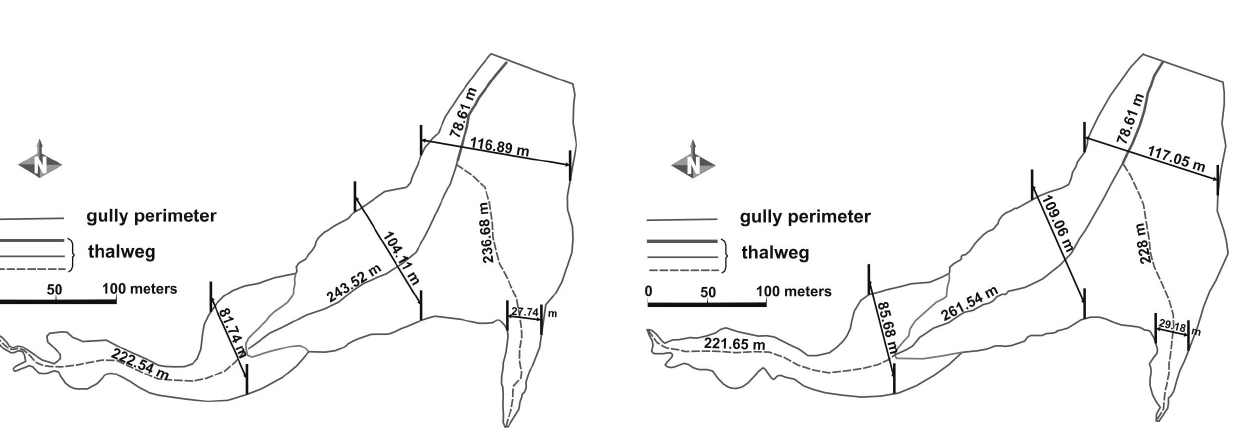
Fig. 6. Morphometric characteristics of the Cucuteni-Baiceni gully.